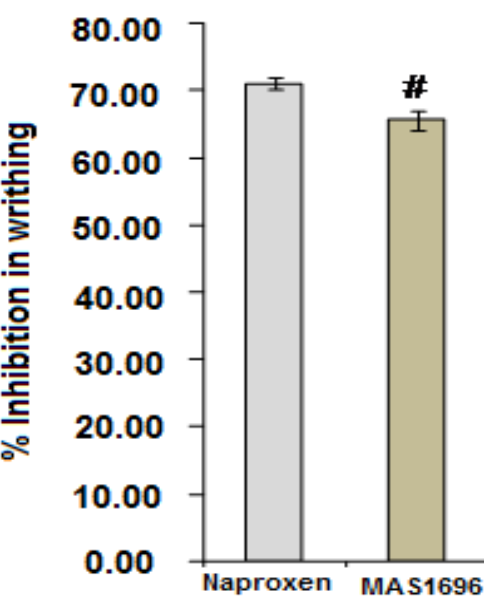
Figure 8. Analgesic activity of S -naproxen and MAS1696. # p < 0.05 as compared to S-naproxen. Results presented are mean ± S.E.M ( n = 6).